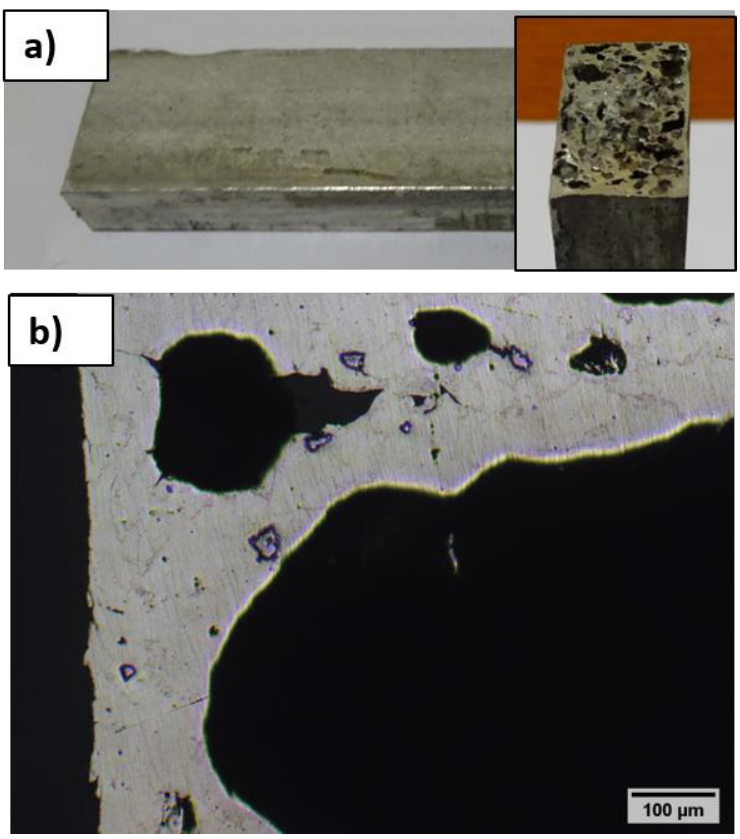
Figure 2. HMF foams, ( a ) visual appearance (top view and cross-section), ( b ) optical microscopy of the cross section (100×, no etching). Table 1. Density, porosity, pore dimension, and skin and cell wall thickness of the Cymat-type foams.